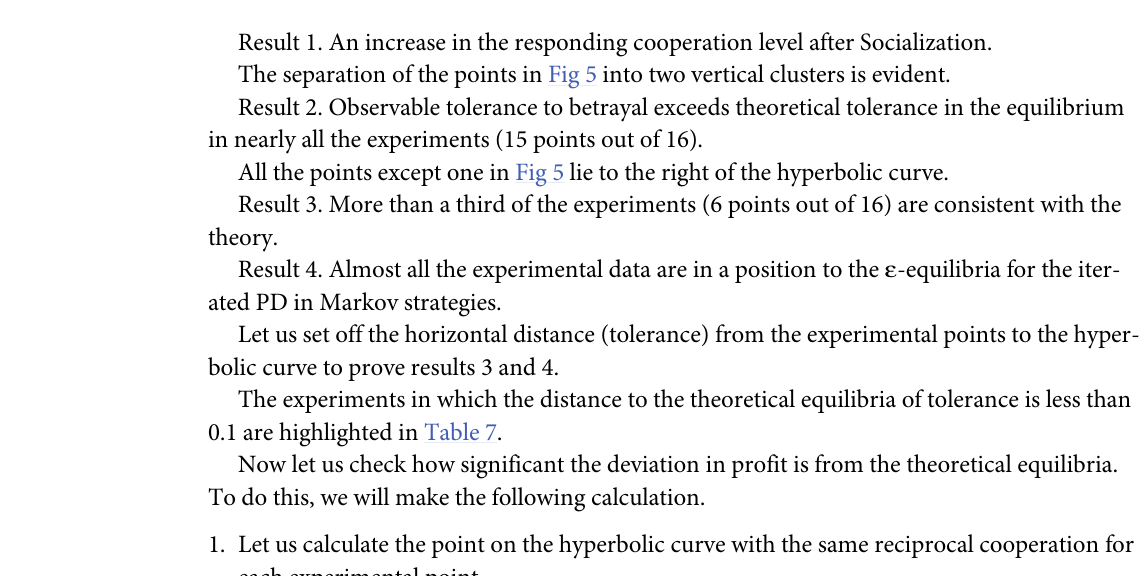
Fig 5. Tolerance to defection and reciprocal cooperation: Theory and experiment. Reciprocalcooperation γ (y-axis) as a function of the toleranceof the defection α (x-axis) for every experiments: comparisonof the theoretical and experimental data.